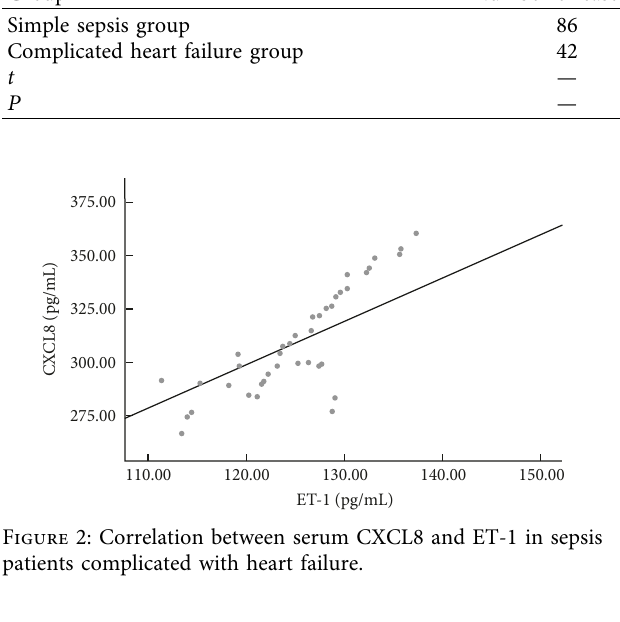
Table 3: Comparison of serum CXCL8 and ET-1 expression levels between the simple sepsis group and the complicated heart failure group. Group